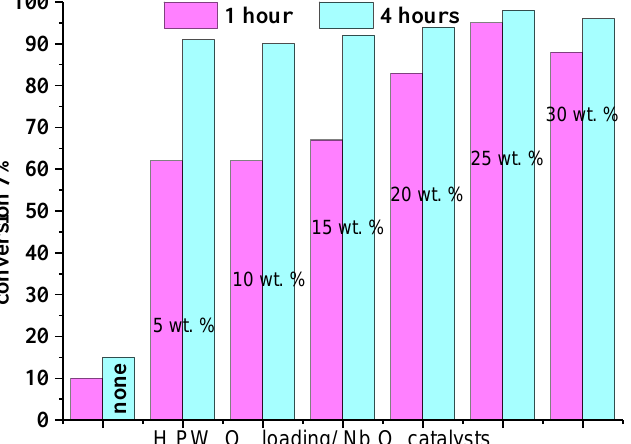
Figure 3. Impact of H 3 PW 12 O 40 load on niobium in the glycerol esterification with HOAc. Reaction conditions: reaction temperature (393 K); catalyst weight (200 mg); glycerol/acetic acid molar ratio (1:5); reaction time (1 h) (adapted from ref. [46]).